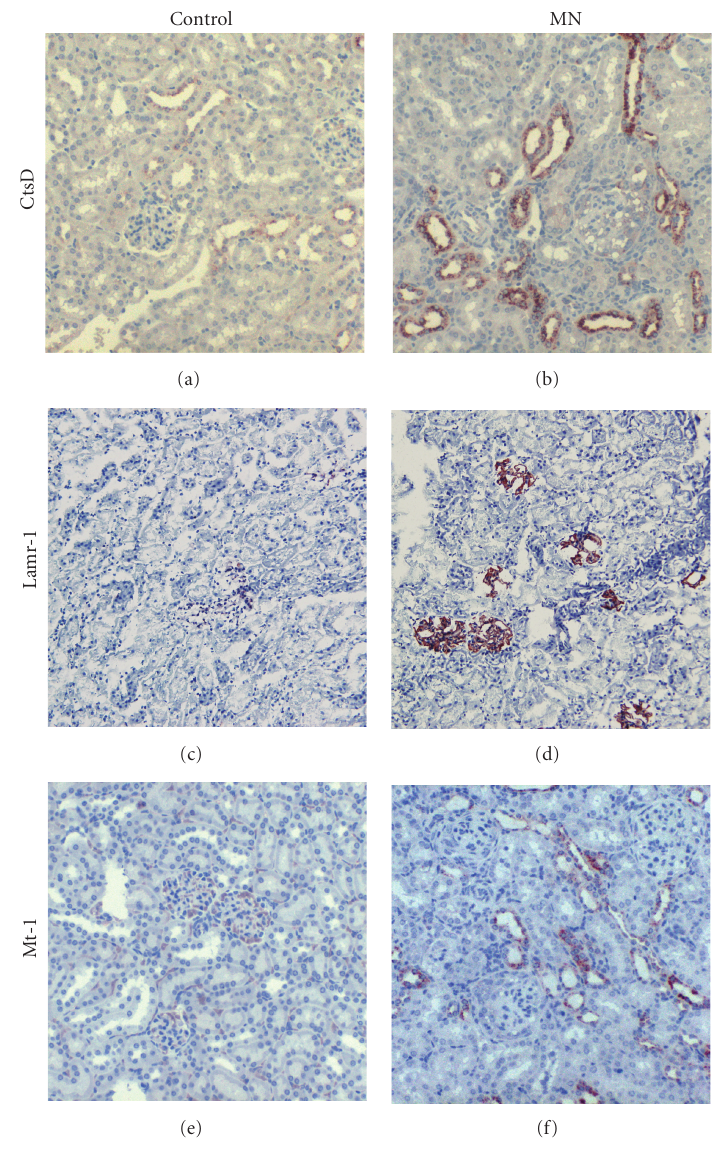
Figure 6: Renal immunohistochemistry of candidate proteins in mice kidneys. Kidneys from mice of the normal control group ((a), (c), and (e)) and membranous nephropathy group ((b), (d), and (f)) were stained for CtsD ((a) and (b)), Lamr-1 ((c) and (d)), and Mt-1 ((e) and (f)). All images are at 400 × magnification. CtsD: cathepsin D; Lamr-1: laminin receptor-1; Mt-1: